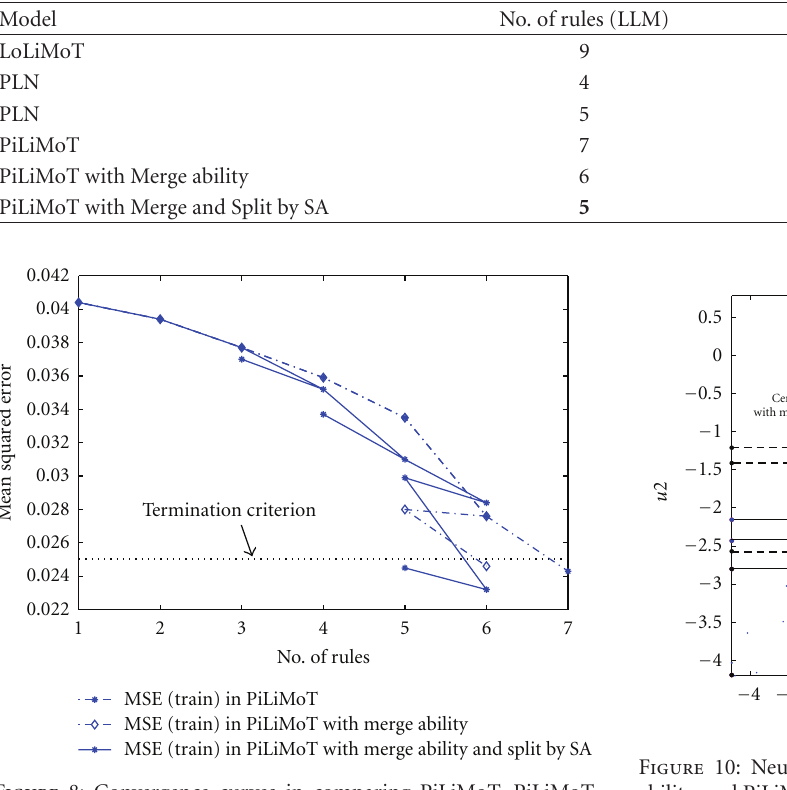
Figure 8: Convergence curves in comparing PiLiMoT, PiLiMoT with Merge ability, and PiLiMoT with Merge ability and modified spilt by SA in training data.